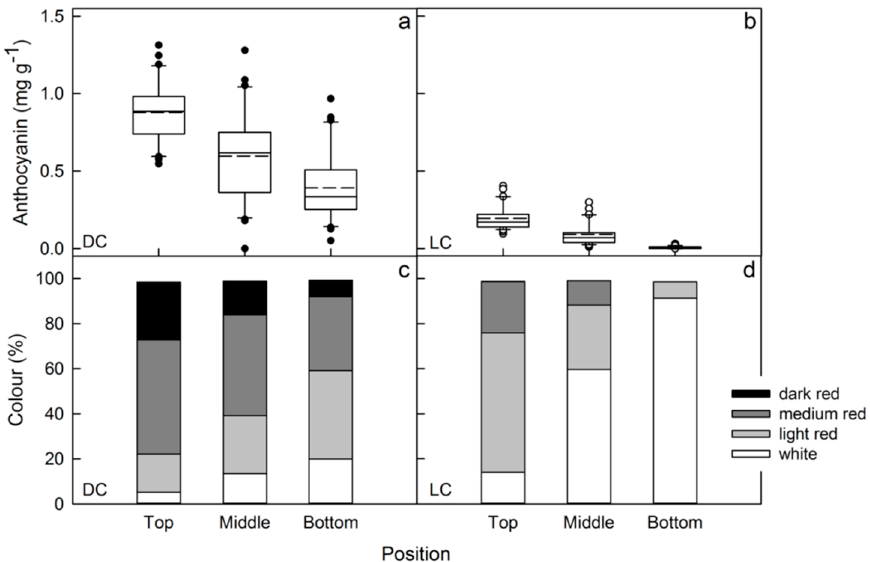
Figure 4. Effects of position along the central axis of a slender spindle tree on flesh anthocyanin content ( a , b ) and the color distribution ( c , d ) of red flesh apples of a dark-colored (DC) ( a , c ) and a light-colored (LC) clone ( b , d ).